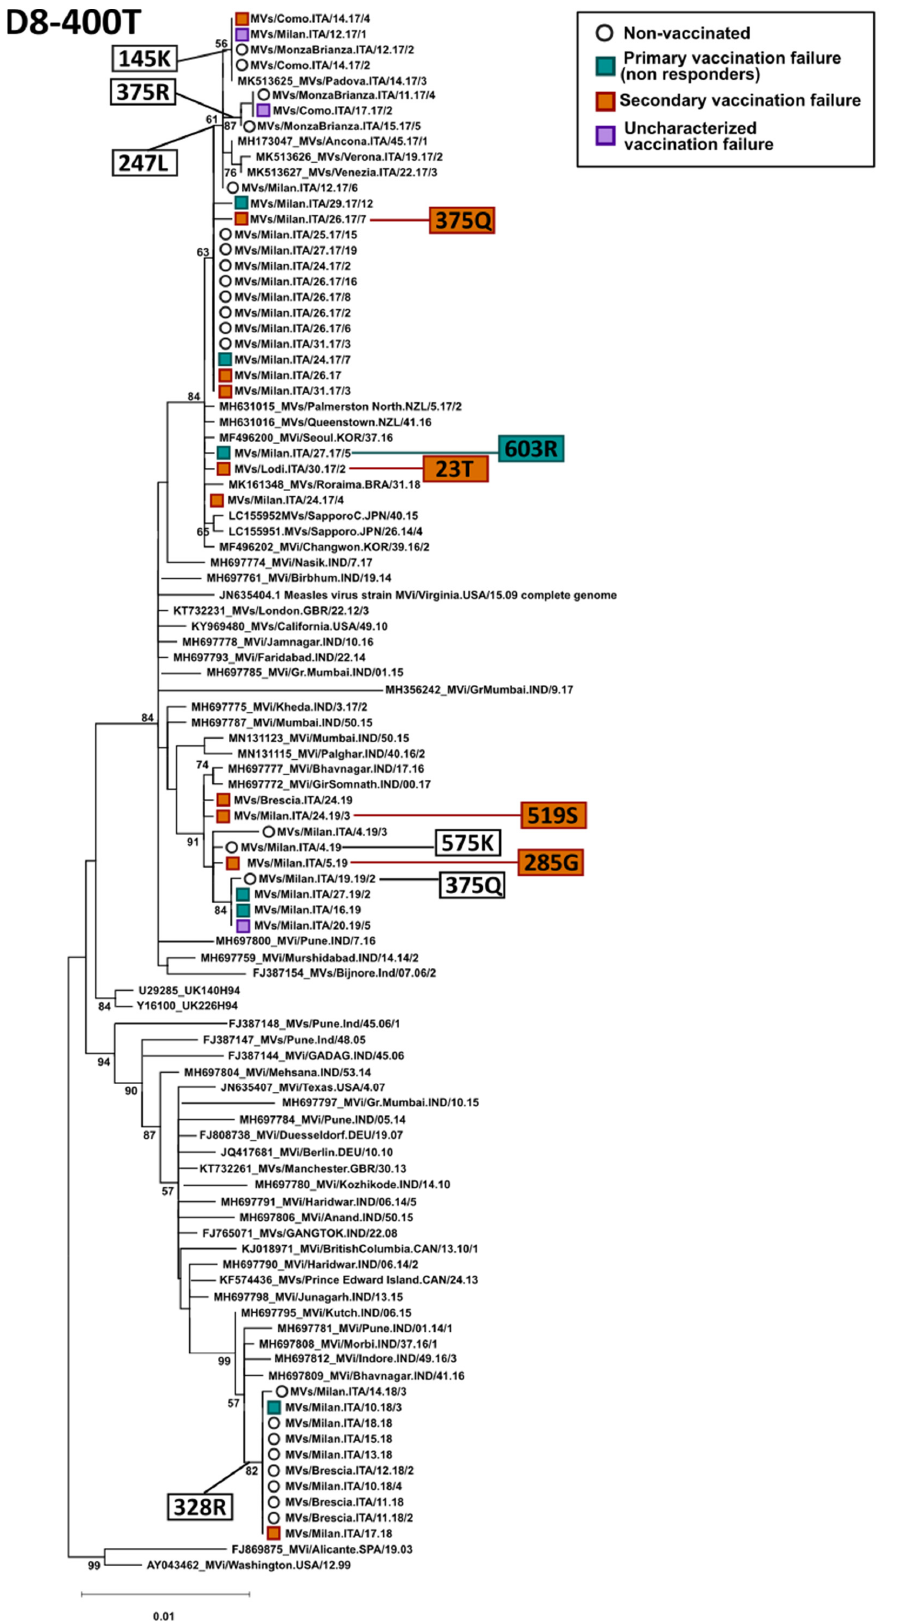
Figure 4. Phylogenetic analysis of genotype D8 H nucleotide sequences belonging to clade